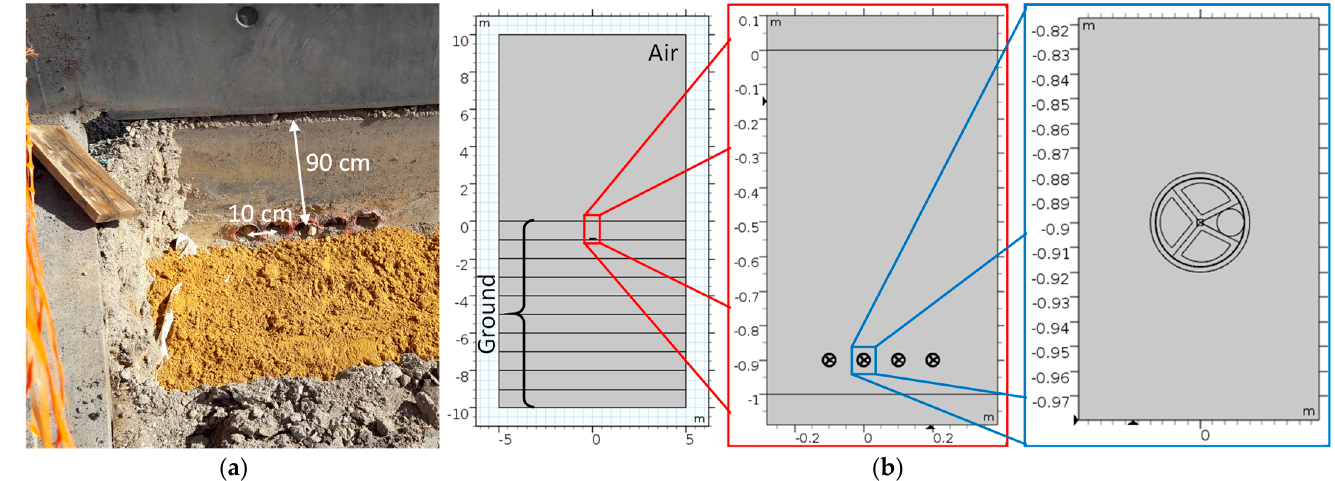
Figure 8. Trench for the exit of LV cables at the MV/LV substation on the university campus ( a ). The dimensions of the trench were used to design the COMSOL FEM model ( b ).